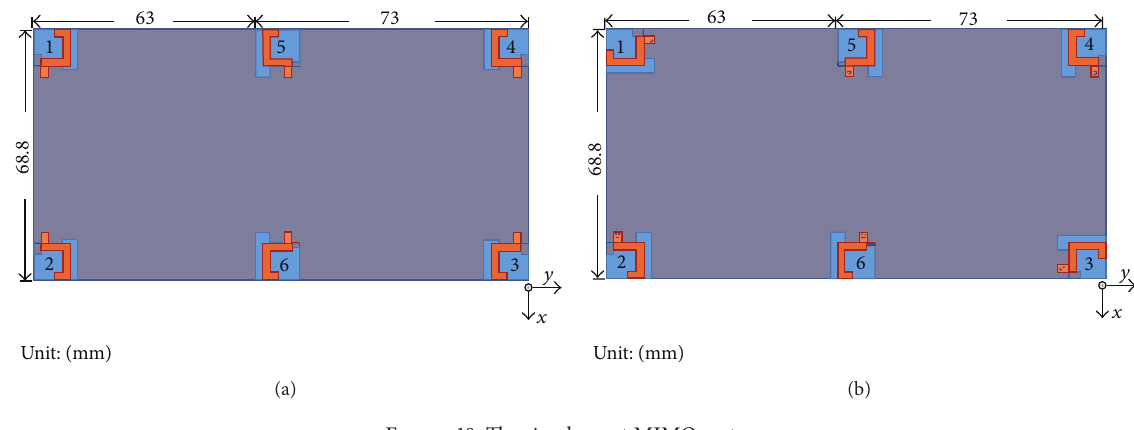
Figure 10: The six-element MIMO